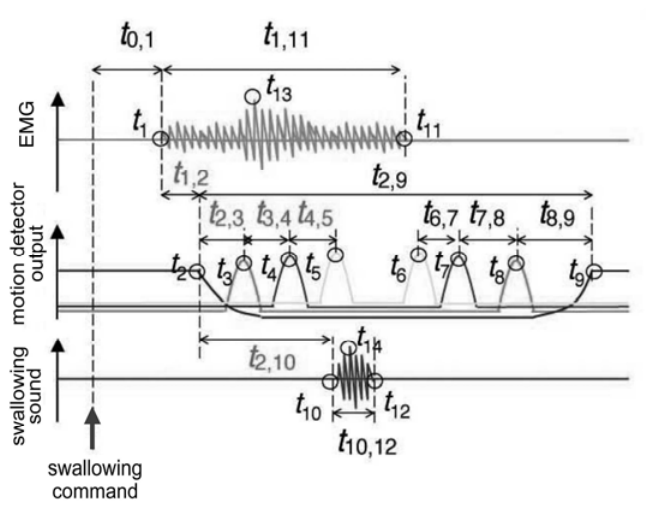
: i = 1,2,...,14} of i : i , j = 1,2,...,12}. i,j